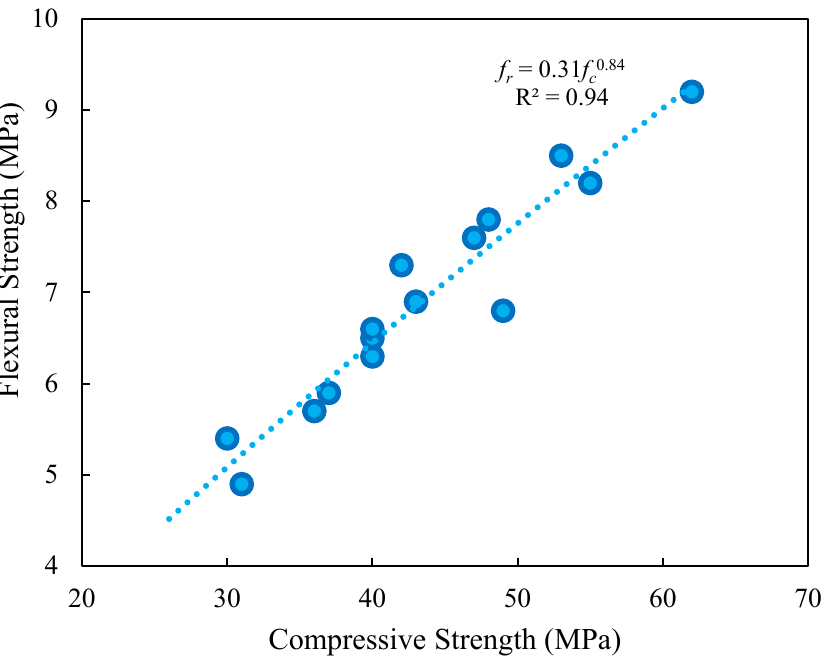
Figure 15. Relationship between compressive resistance and fracture energy of concrete containing different PF and RTA fractions.